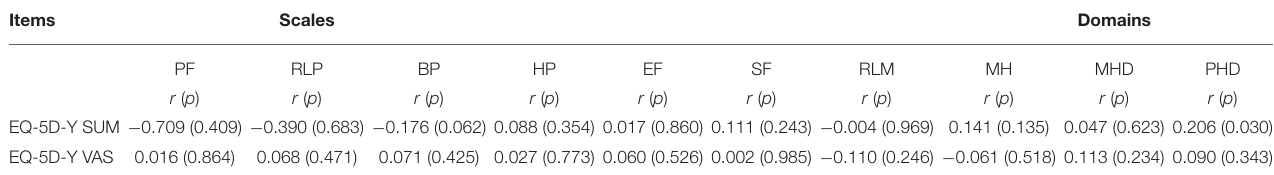
TABLE 5 | Correlation of each of the EQ-5D-Yor (Sum) and EQ-5D-Yor (VAS) with the scales and domains of the Yoruba version of the SF-12 (Convergent validity). Items Scales Domains PF RLP BP HP EF SF RLM MH MHD PHD r ( p ) r ( p ) r ( p ) r ( p